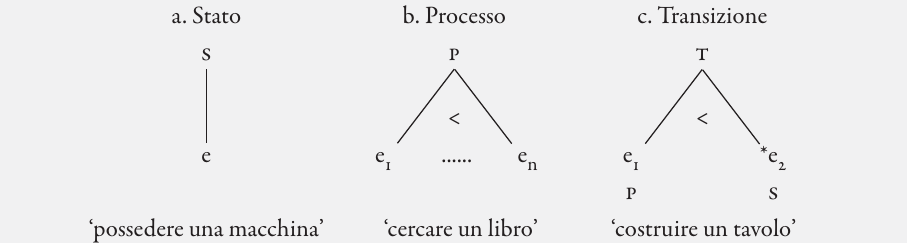
Figura 1 . Rappresentazione formale di stati, processi e transizioni in base al